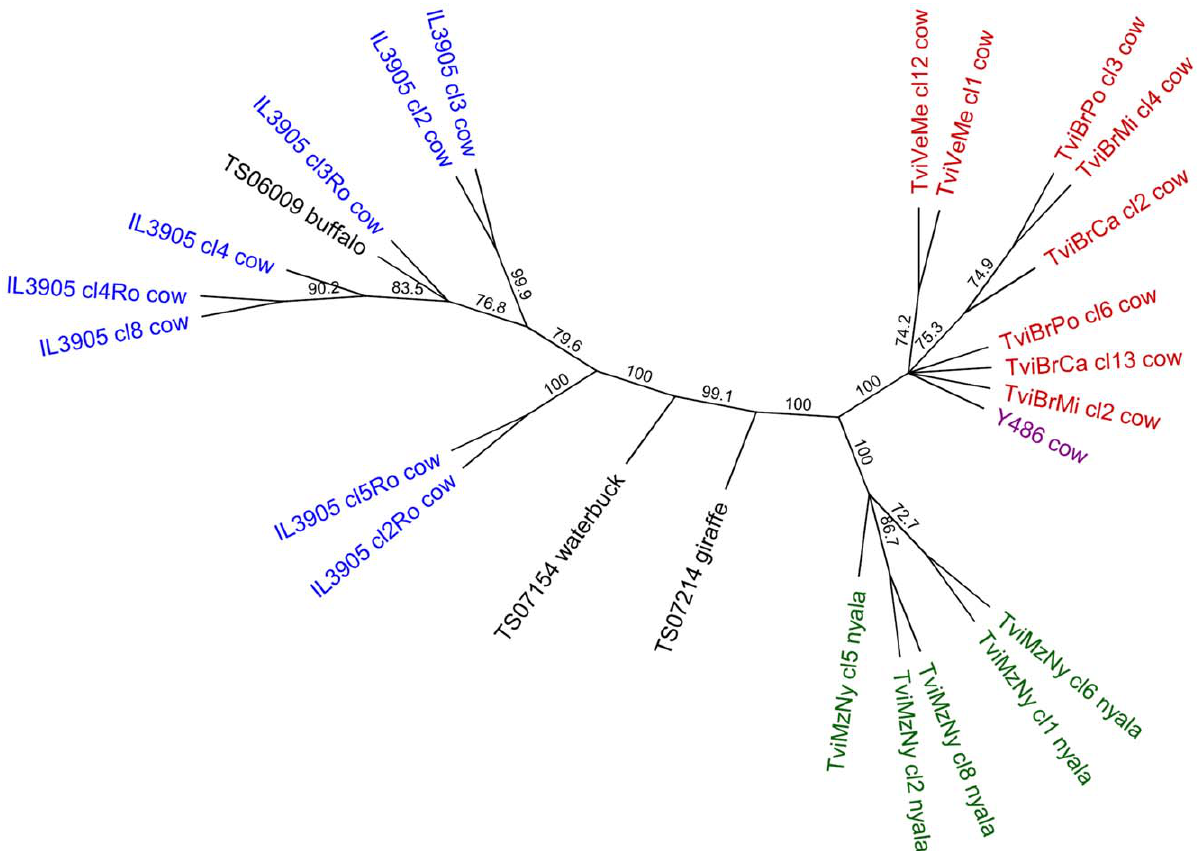
Figure 2. Unrooted neighbour-joining dendrogram of ITS1, 5.8S and ITS2 sequences for Trypanosomavivax . Bootstrap values are shown at nodes with . 70% support. Sequences generated in this study shown in black; other sequences retrieved from Genbank and listed in Table 3. Sequence locations are shown by colour: Tanzania (this study, black); Kenya (blue); Mozambique (green); Nigeria (purple); South America (red). Host species from which sequence was amplified are indicated. Accession numbers for reference sequences are: IL3905 cl8, Genbank ID:DQ316040; IL3905 cl4Ro, DQ316043; IL3905 cl4, DQ316039; IL3905 cl3Ro, DQ316042; IL3905 cl2Ro, DQ316041; IL3905 cl5Ro, DQ316044; IL3905 cl2 DQ316037; IL3905 cl3, DQ316038; TviBrMi cl4, DQ316048; TviBrPo cl13, DQ316049; TviBrCa cl2, DQ316045; Y485, U22316; TviBrMi cl2, DQ316047; TviVeMe cl1, DQ316051; TviVeMe cl12, DQ316052; TviBrCa cl13, DQ316046; TviBrPo cl6, DQ316050; TviMzNy cl5, EU482080; TviMzNy cl2, EU482079; TviMzNy cl8, EU482082; TviMzNy cl1, EU482078; TviMzNy cl6,